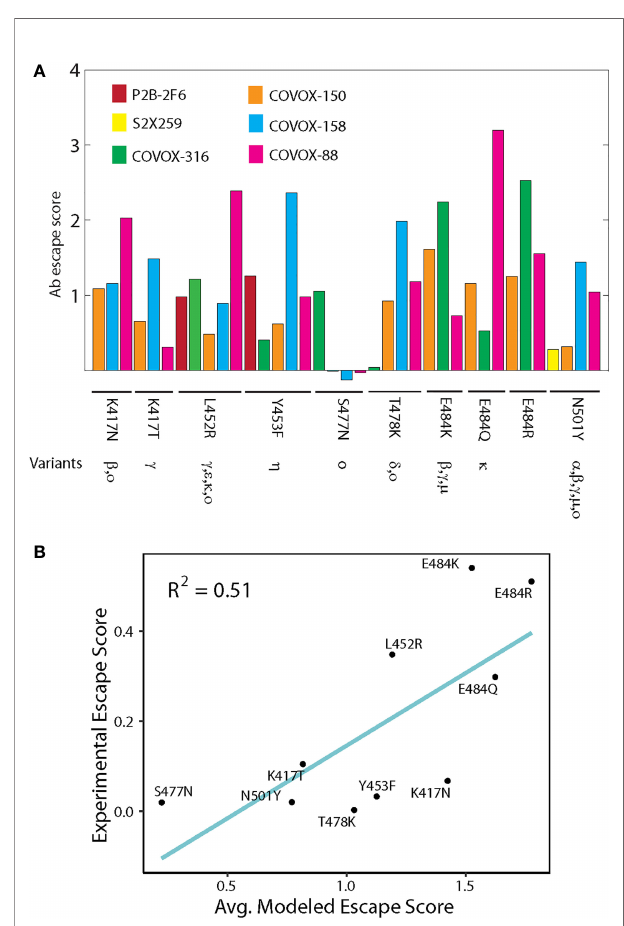
FIGURE 4 | Antibody escape scores of point mutations from non-Omicron variants. (A) Escape scores of point mutations for six neutralizing antibodies targeting S RBD. Occurrence of mutations in different variants is indicated. (B) Correlation between predicted and experimentally measured antibody escape scores. The two approaches used different sets of antibodies targeting S RBD. The experimental score is the sum of contributions from ten